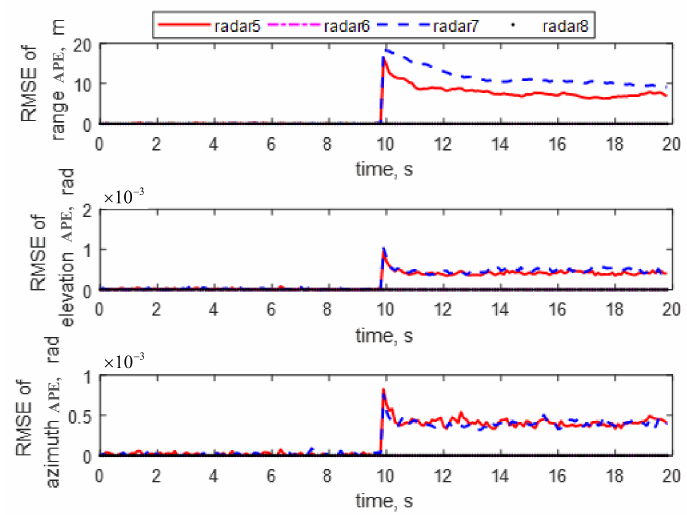
Figure 8. RMSE of the attack parameter estimations for radars 5–8.